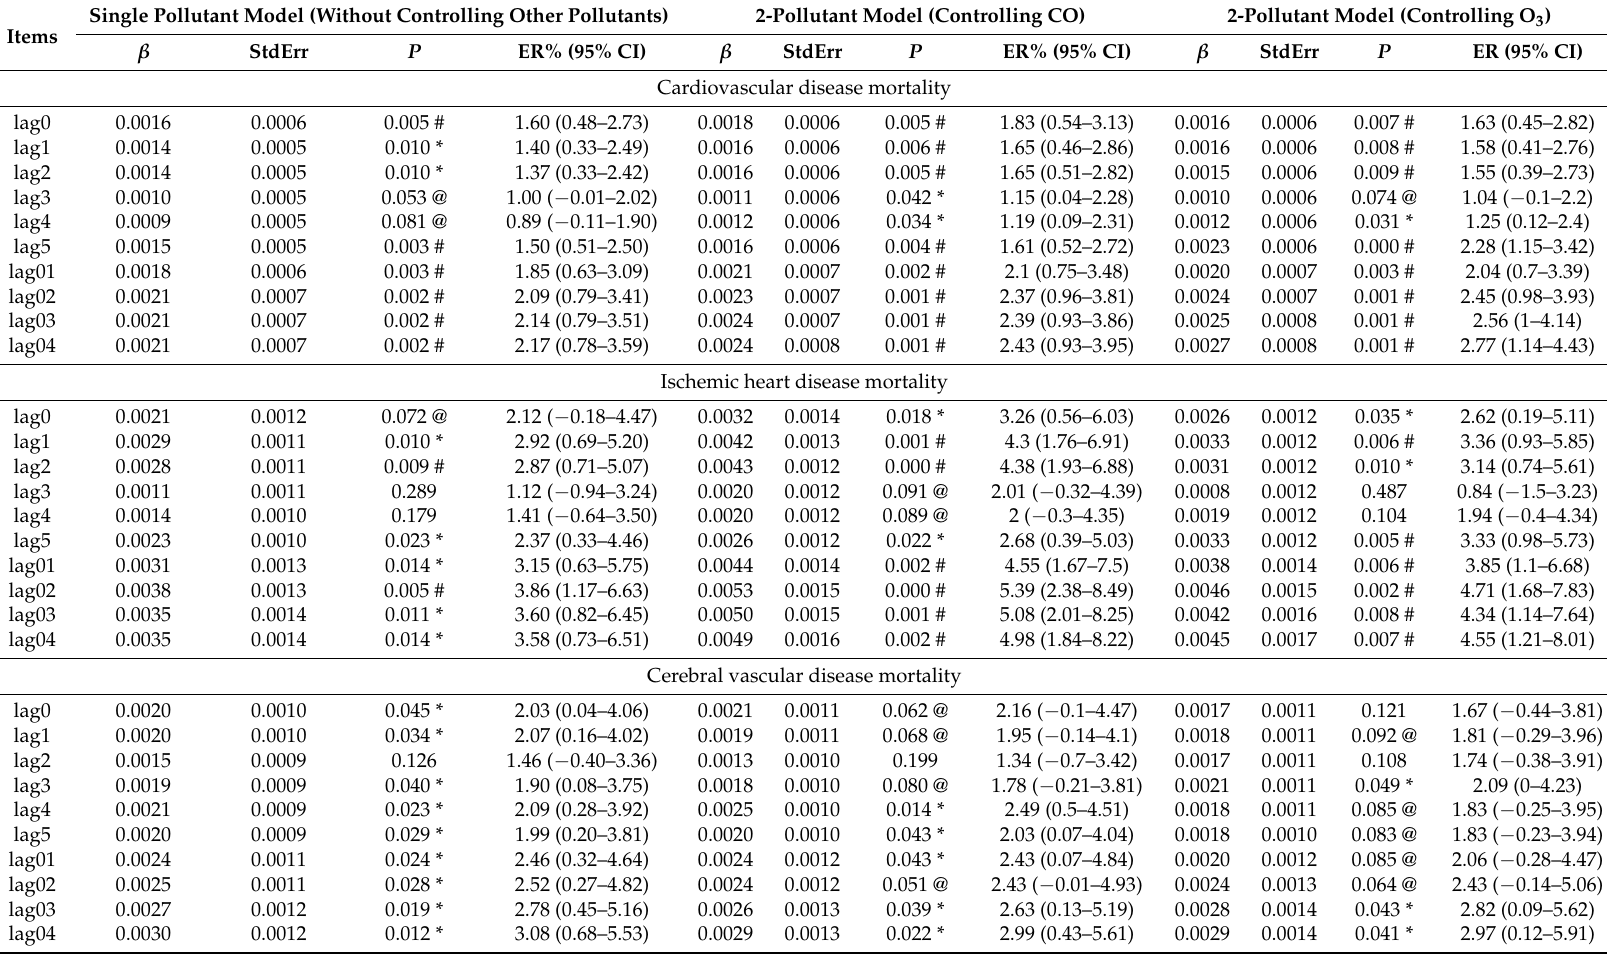
Table 5. The effects of PM 2.5 concentration on CVD, IHD and EVD mortality without controlling other pollutants and controlling CO or O 3 in Shenzhen